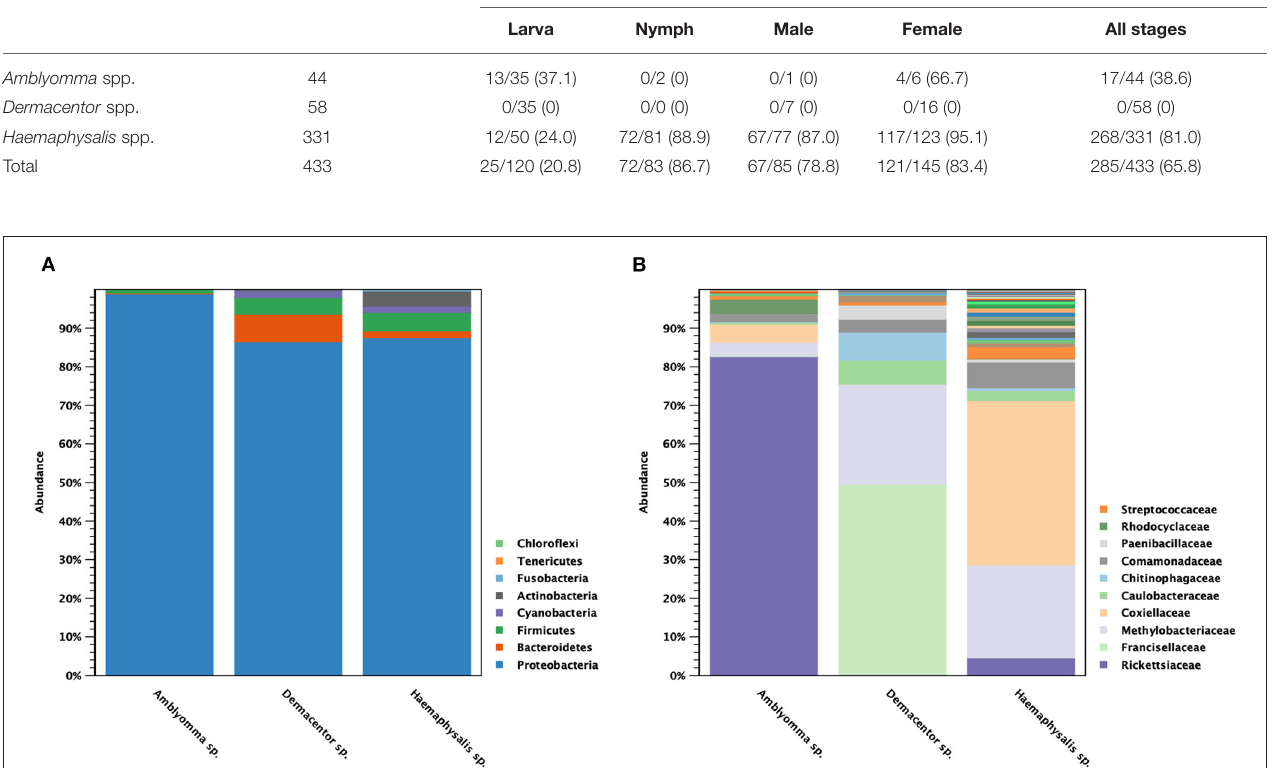
FIGURE 3 | Taxonomic diversity and relative abundance at the phylum (A) and family (B) level of bacterial community in questing ticks. The percent relative abundances are of the total number of OTUs. Color legend for each phylum (A) or family (B) was indicated next to the bar graph.